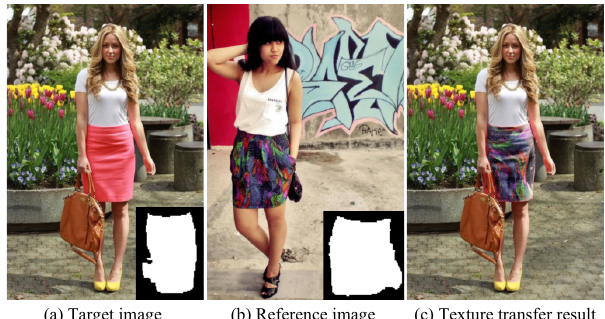
Fig. 6 Garment texture transfer. We calculate texture coordinates both for the (a) target and (b) reference images from the contours of skirt masks (shown as insets) and then (c) transfer the texture of the reference to the